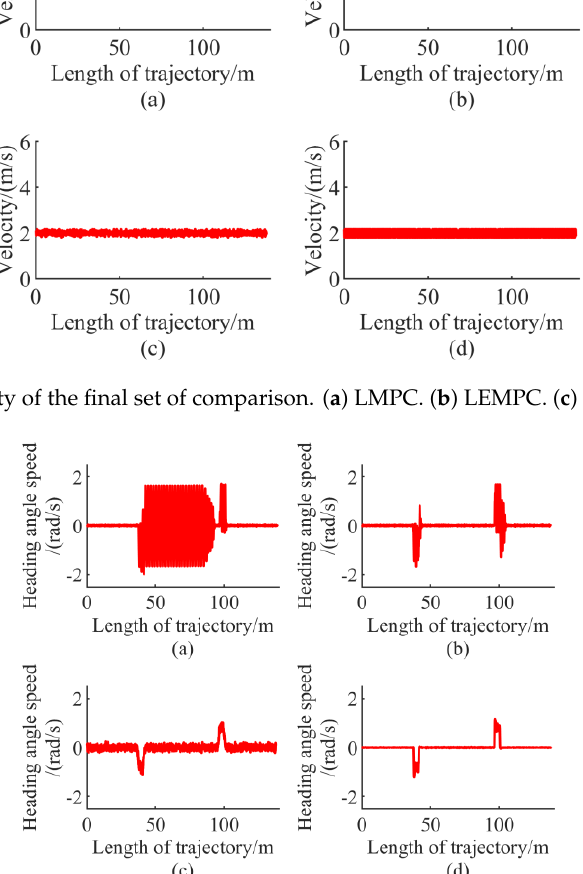
Figure 41. The heading angle speed of the final set of comparison. ( a ) LMPC. ( b ) LEMPC. ( c ) NMPC. ( d ) NEMPC.